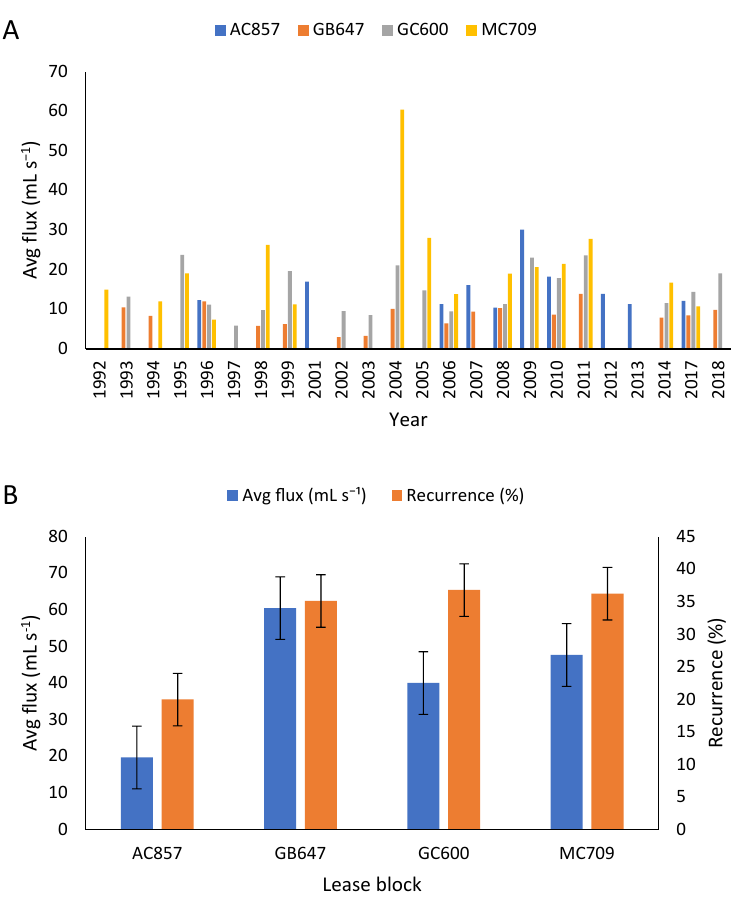
Figure 6. ( A ) Temporal variability of average flux in lease blocks extending from west (AC857) to east (MC709) across the Gulf of Mexico. ( B ) Zonal variation of average flux and recurrence rates in lease blocks. Error bars represent standard error.